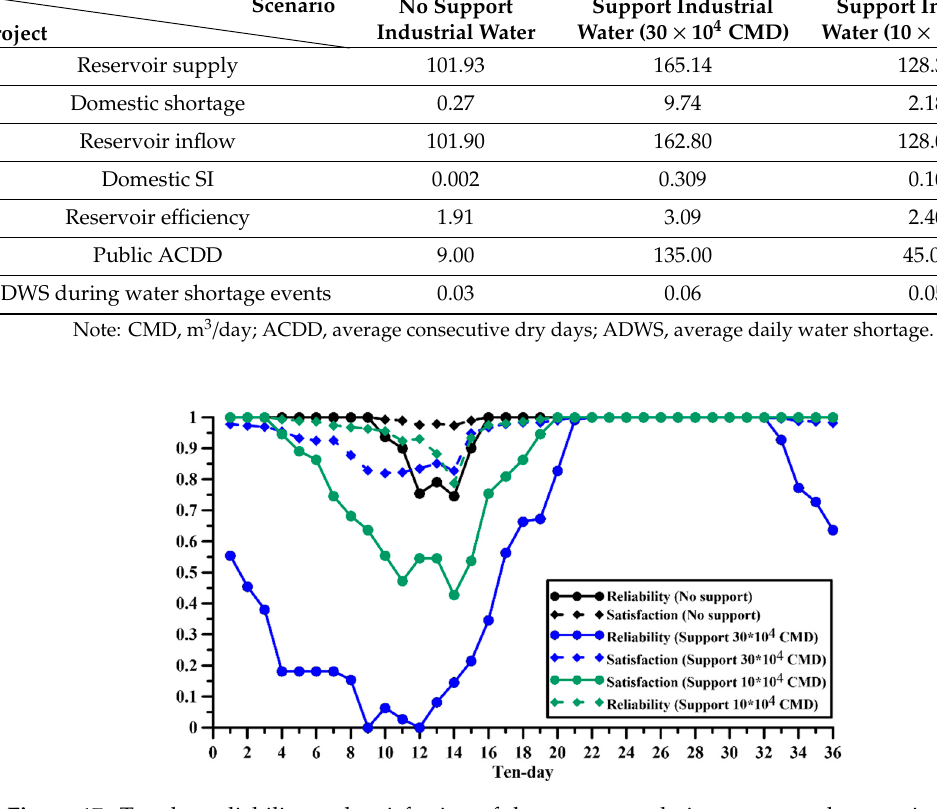
Figure 17. Ten-day reliability and satisfaction of the water supply in present each scenario. CMD, m 3 /day.